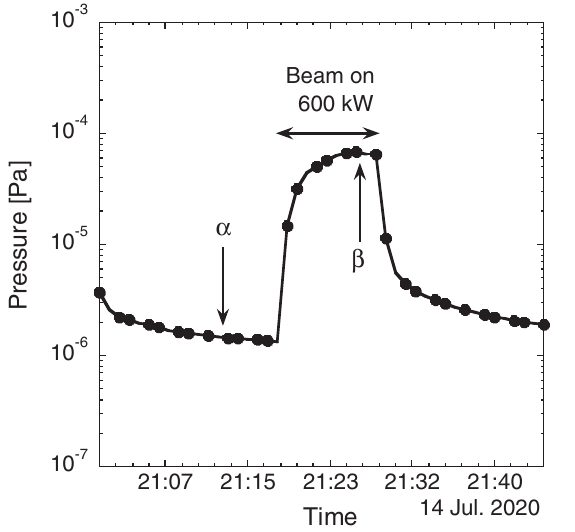
FIG. 5. Example of pressure rise during high-power beam operation. Pressure evolution during the beam commissioning with an output beam power of 600 kW is plotted. The pressure measured by a CCG in C15 of the second arc section is shown in this figure as a typical case.